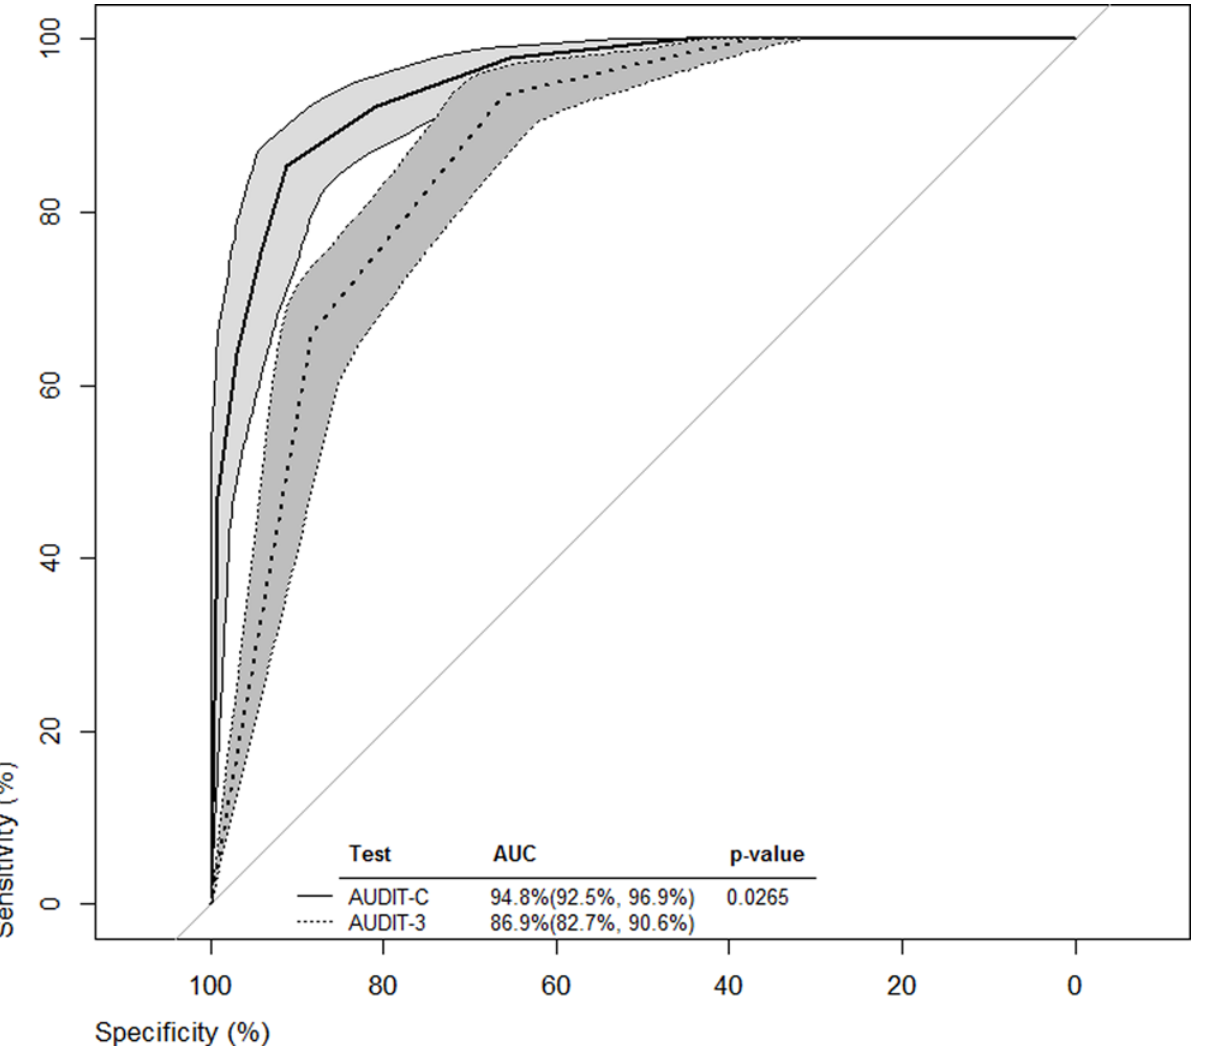
Fig 2. ROC curves for women from all cut-off values for both AUDIT-C and